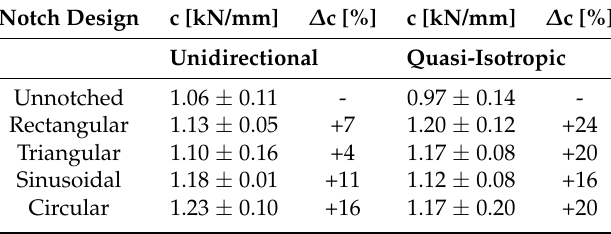
Average stiffness and corresponding standard deviation values evaluated for different circumferentially notched z-pins inserted in unidirectional and quasi-isotropic laminates. The percentage of variation in stiffness in comparison to unnotched z-pins is also reported. Notch Design c [kN/mm] ∆ c [%] c [kN/mm] ∆ c [%] Unidirectional